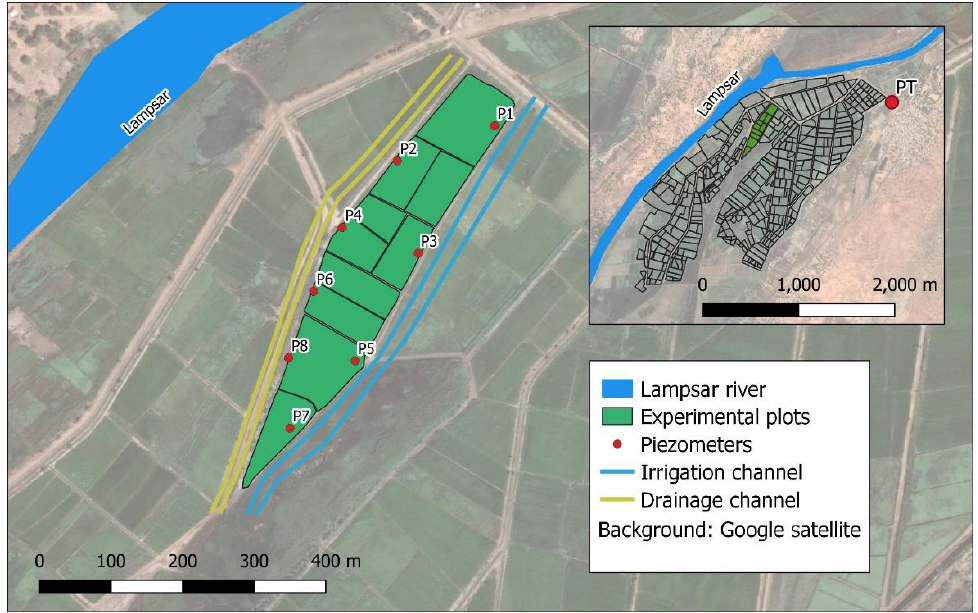
Figure 2. Location of piezometers in the Ndiaye site.